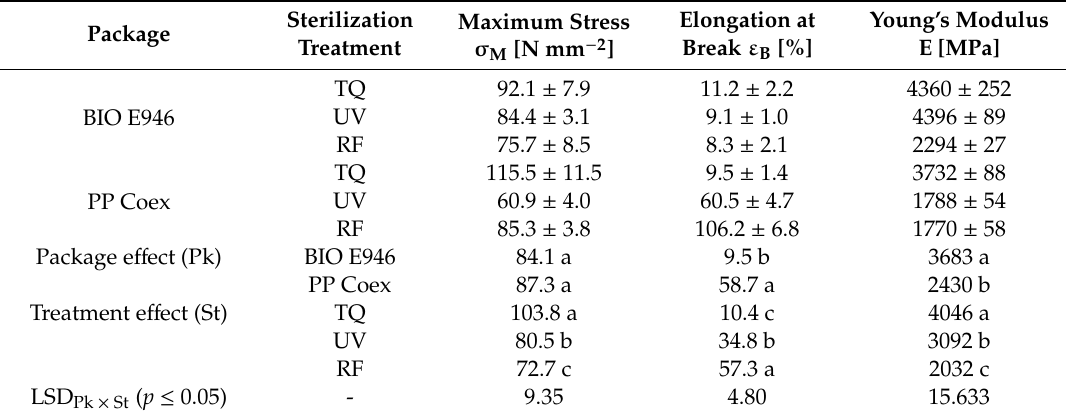
Table 1. Changes in maximum load, elongation at break and Young’s modulus in relation to package (BIO E946 = biodegradable film; PP Coex = conventional film) and sterilization treatment (TQ = original sample, UV = UV treated film; RF = RF treated sample).